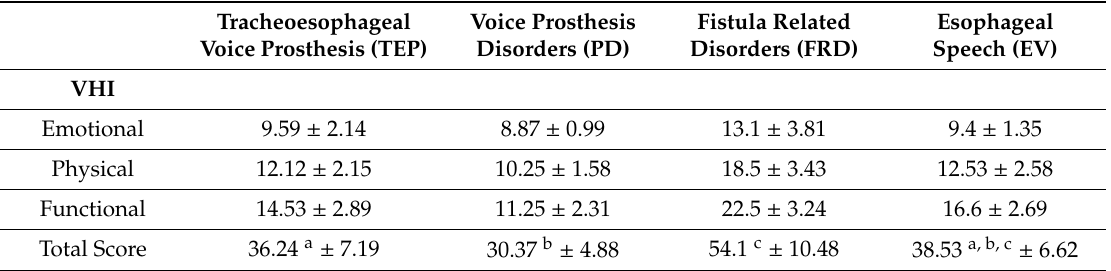
Table 4. Comparison of each sub-classes voice handicap index (VHI) scores. Statistical significance at p <